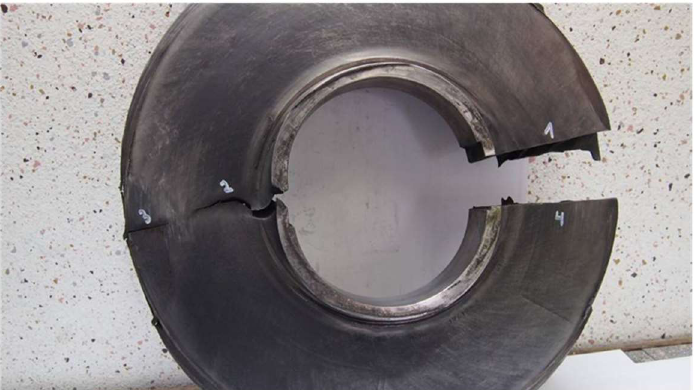
Figure 1. Failed impeller of the first stage.